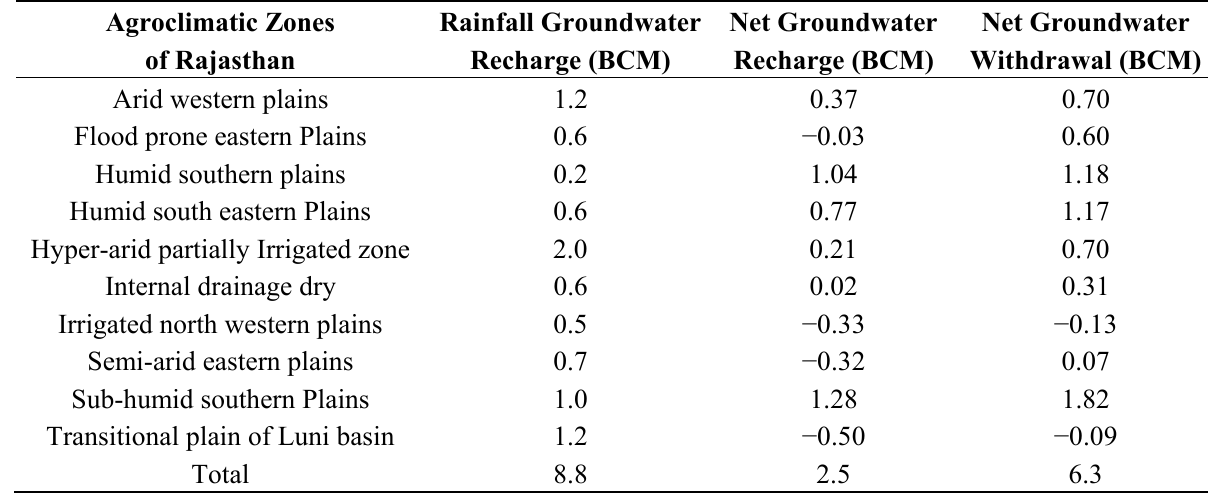
Table 2. Average annual rainfall recharge, net groundwater recharge (GRACE) and net groundwater withdrawal (GRACE) estimates.